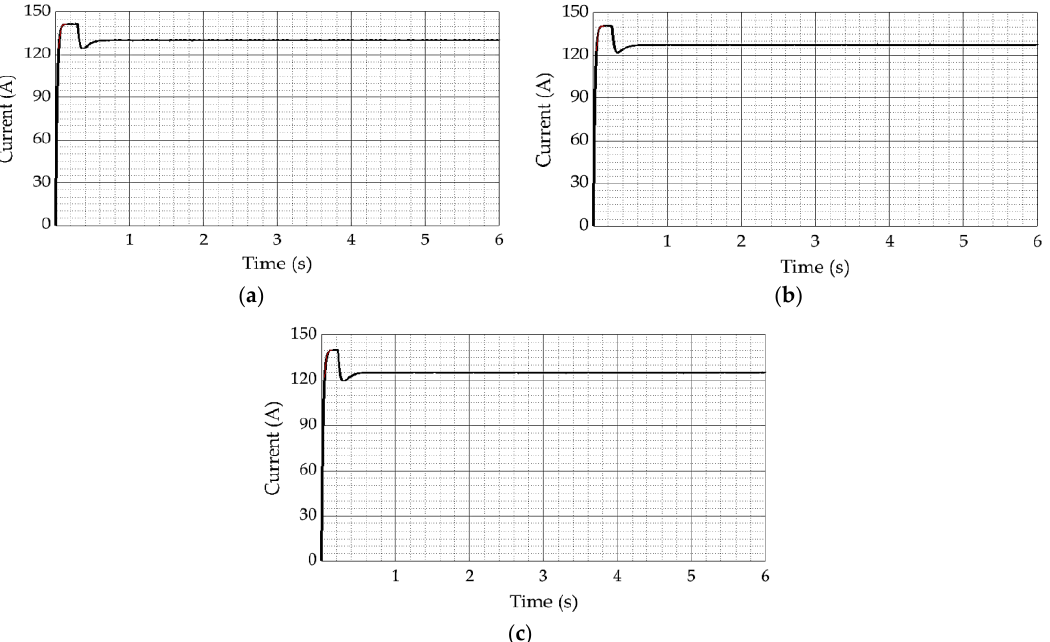
Figure 13. The output DC current of Level 3 charging for ( a ) nickel metal, ( b ) lithium ion, and ( c ) lead acid batteries.